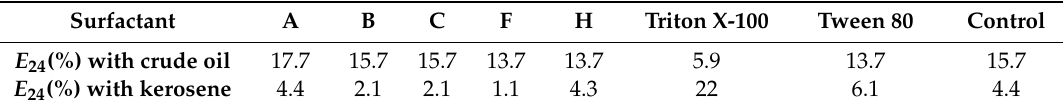
Table 4. Emulsification index E 24 of di ff erent surfactants (500 mg / L solutions) tested with crude oil and kerosene.